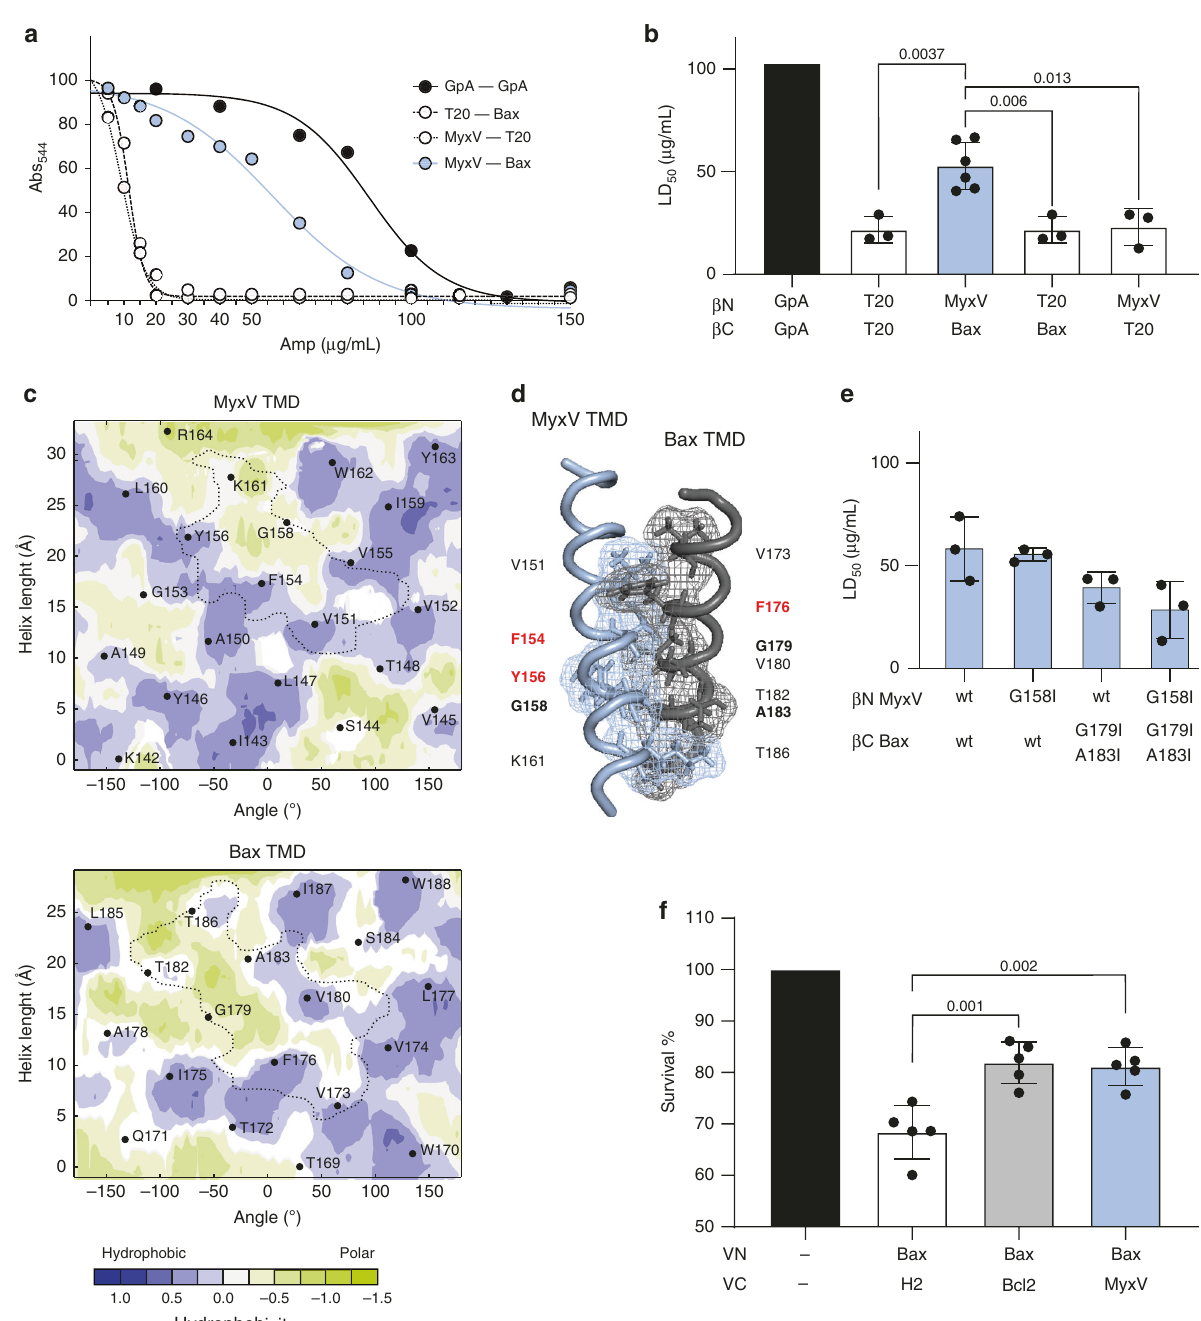
Fig. 5 Interaction between MyxV and Bax TMDs. a Representative example of dose – response curves used to calculate LD 50 values in the BlaTM assay. The TMD homodimer of GpA was used as a positive control (black), while the T20 TMD was used as a negative control (white). b Summary of the results for the BlaTM assay. The indicated β N and β C chimeras were expressed in E. coli and the resulting ampicillin LD 50 measured. LD 50 mean and standard deviation of at least three independent experiments ( n ≥ 3) are shown. Two-tailed homoscedastic t -test p -values are indicated. Solid dots represent the results of individual experiments. c Predicted (PredDIMER) contact area between MyxV and Bax TMDs. The position (length and angle) of each residue in a putative α -helix is indicated. A dotted line encircles the contact area in each TMD. The hydrophobicity of the residues is shown with a color scale. d Model of a putative dimer between MyxV TMD and Bax TMD, obtained with PredDIMER. The residues involved in the interaction are indicated. Glycine and alanine residues are highlighted in bold while aromatic residues are shown in red. e BlaTM analysis for the interaction between MyxV and Bax TMDs carrying substitutions of Gly 158 (MyxV) and/or Gly 179 and Ala 183 (Bax) by Ile. LD 50 mean and standard deviation of at least three independent experiments are shown ( n ≥ 3), solid dots represent the results of individual experiments. f Bax TMD-induced cell death. Cells were transfected with Bax TMD and H2, Bcl2 or MyxV TMD or mock-transfected; 24 hpt cell viability was measured by Trypan blue staining. Survival percentage mean and standard deviation of fi ve independent experiments ( n = 5) are shown. Two-tailed homoscedastic t -test p -values are indicated. Solid dots represent the results of individual